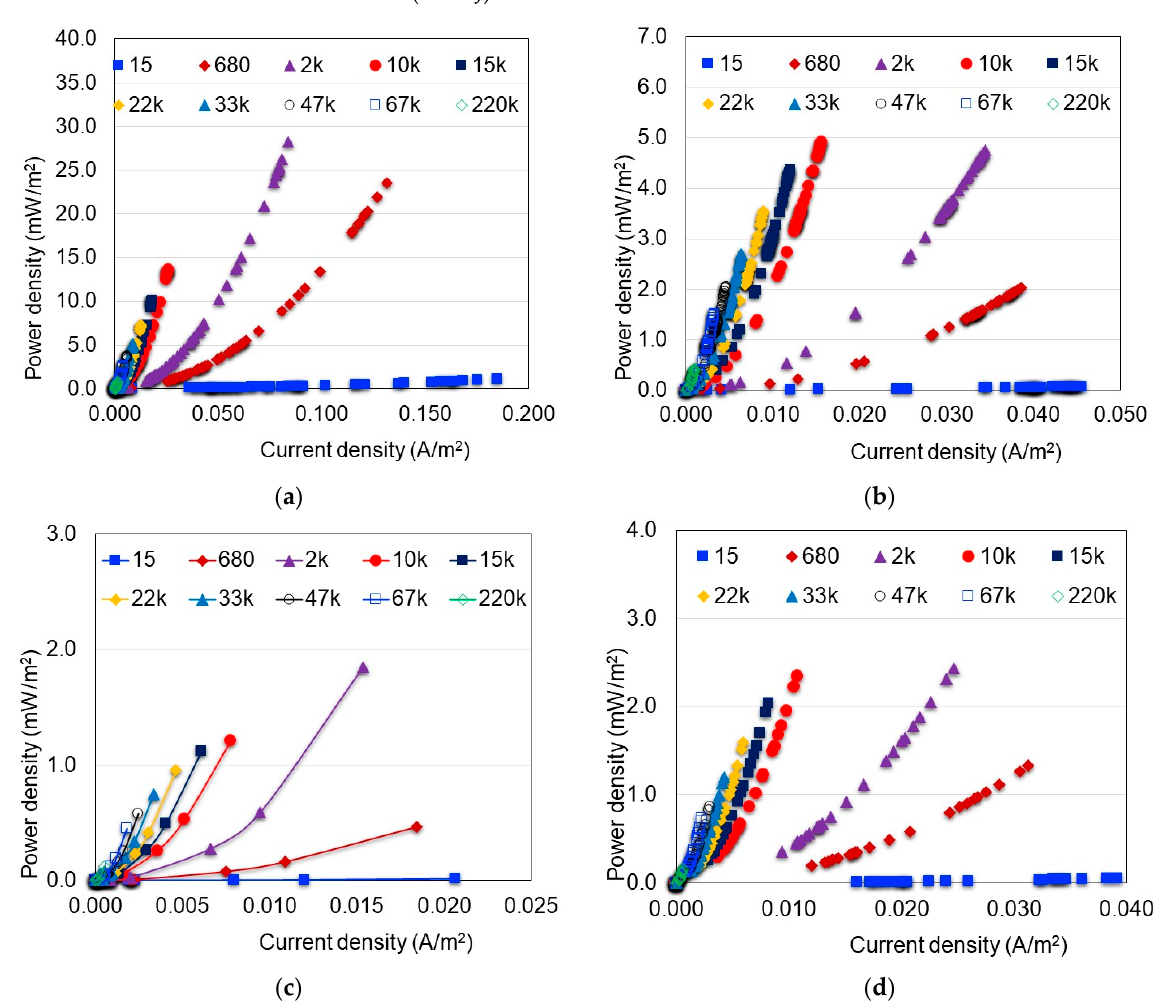
Figure 7. E ff ect of the external resistance ( Ω ) on the MFC power density. ( a ) Water and hydrophil- Figure 7. Effect of the external resistance ( Ω ) on the MFC power density. ( a ) Water and ically-treated graphene (DW-HTG); ( b ) HCl and hydrophilically-treated graphene (HCl-HTG); ( c ) hydrophilically-treated graphene (DW-HTG); ( b ) HCl and hydrophilically-treated graphene (HCl- Water and graphite (DW-G); ( d ) HCl and graphite (HCl-G). HTG); ( c ) Water and graphite (DW-G); ( d ) HCl and graphite (HCl-G). For HCl as a catholyte and hydrophilically-treated graphene electrode, the maximum For HCl as a catholyte and hydrophilically-treated graphene electrode, the maximum power density obtained was 4.75 mW/m 2 and 33.58 mW/m 3 and the total energy generated power density obtained was 4.75 mW/m 2 and 33.58 mW/m 3 and the total energy generated was 1.772 Wh (6379 J). The di ff erence between both scenarios was due to the slow initial was 1.772 Wh (6379 J). The difference between both scenarios was due to the slow initial response of the electrochemical active microorganisms under acidic conditions; however, response of the electrochemical active microorganisms under acidic conditions; however, as the reaction time running these microorganisms showed a steadily increasing activity as the reaction time running these microorganisms showed a steadily increasing activity and energy generation (Figure 7b), a greater power density could be expected at reaction and energy generation (Figure 7b), a greater power density could be expected at reaction times longer than the used in this study, such as when graphite was used as a catholyte; times longer than the used in this study, such as when graphite was used as a catholyte; the current density was greater when HCl was used as a catholyte. For the scenario with distilled water and graphite electrode (Figure 7c), the maximum power density was 1.85 mW/m 2 and 13.09 mW/m 3 and the total energy generated through the experiment was 0.037 Wh (133.56 J). For HCl as a catholyte and graphite electrode (Figure 7d), the maximum power density obtained was 2.43 mW/m 2 and 17.18 mW/m 3 and the total energy generated was 0.431 Wh (1551.60